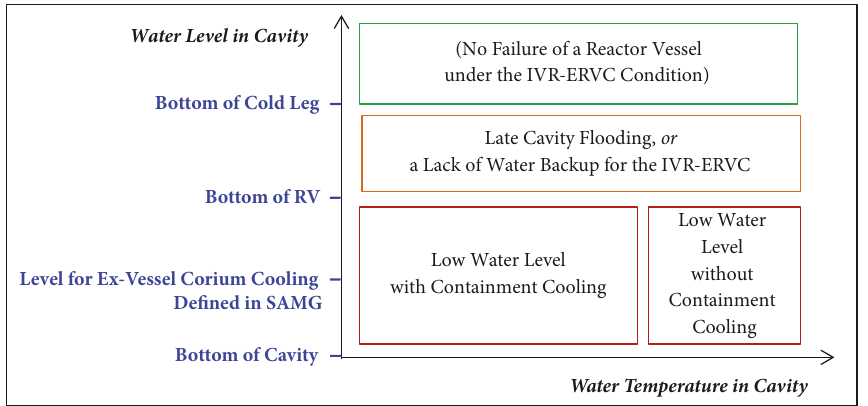
Figure 1: Water conditions in cavity and causes of the conditions when a reactor vessel